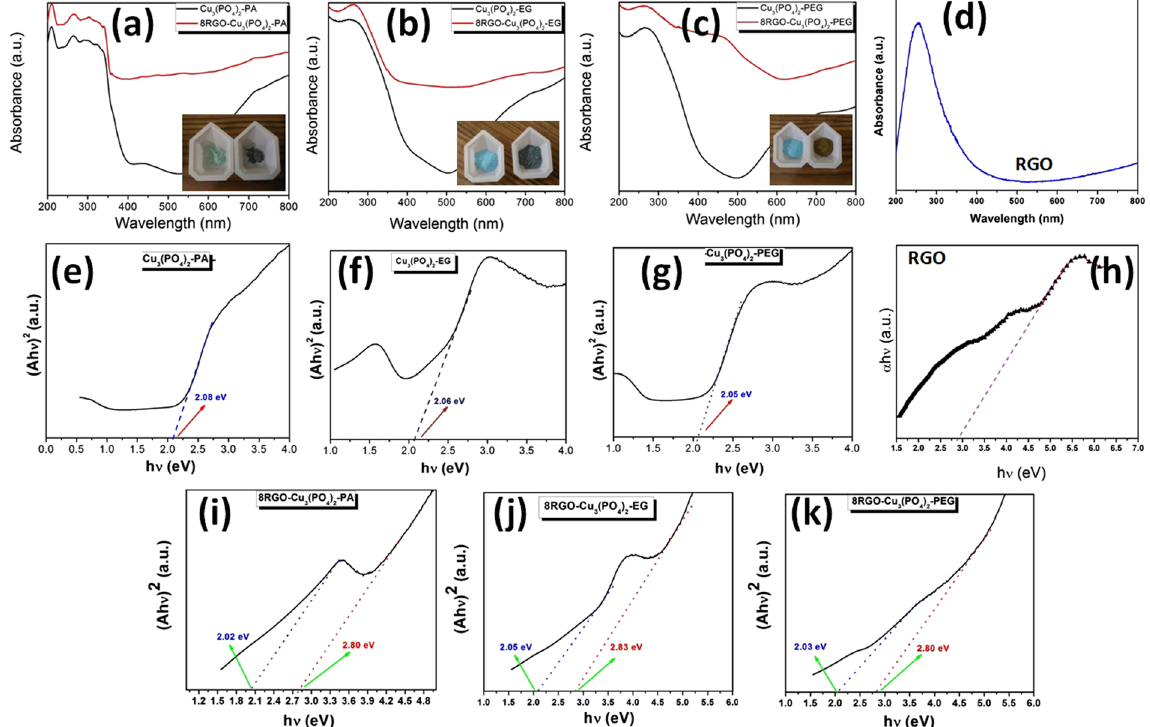
Figure 8. UV-vis diffuse reflectance spectra (DRS) of ( a ) Cu 3 (PO 4 ) 2 -PA and 8RGO-Cu 3 (PO 4 ) 2 -PA ( b ) Cu 3 (PO 4 ) 2 -EG and 8RGO-Cu 3 (PO 4 ) 2 -EG ( c ) Cu 3 (PO 4 ) 2 -PEG and 8RGO-Cu 3 (PO 4 ) 2 -PEG ( d ) RGO. (Inset: images showing the color of the respective samples). Band gap (Eg) determination for ( e ) Cu 3 (PO 4 ) 2 -PA ( f ) Cu 3 (PO 4 ) 2 -EG ( g ) Cu 3 (PO 4 ) 2 -PEG ( h ) RGO ( i ) 8RGO-Cu 3 (PO 4 ) 2 -PA ( j ) 8RGO-Cu 3 (PO 4 ) 2 -EG and ( k ) 8RGO-Cu 3 (PO 4 ) 2 -PEG samples using the Kubelka-Munk function of the diffuse reflectance (R) from Ultraviolet-visible diffuse reflectance spectra. The intercepts of the extrapolated straight lines give the corresponding band gaps of Cu 3 (PO 4 ) 2 and RGO in each